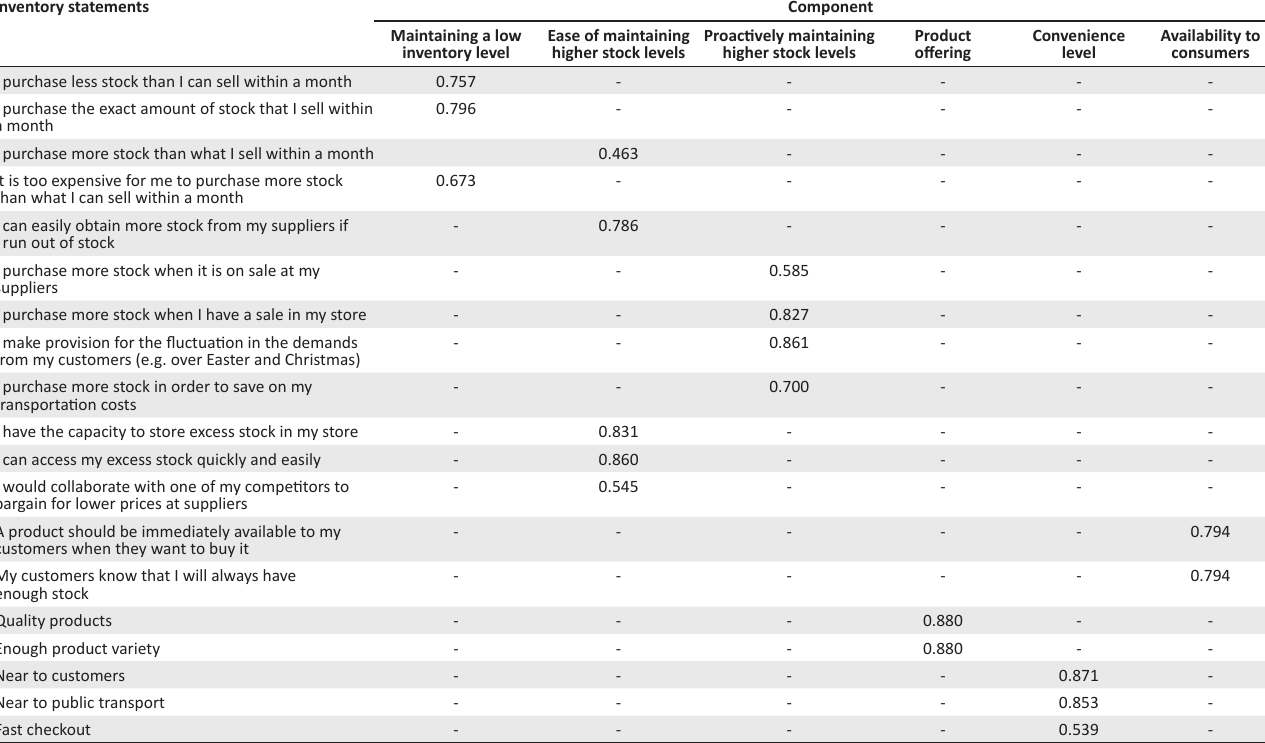
TABLE 1: Final factor